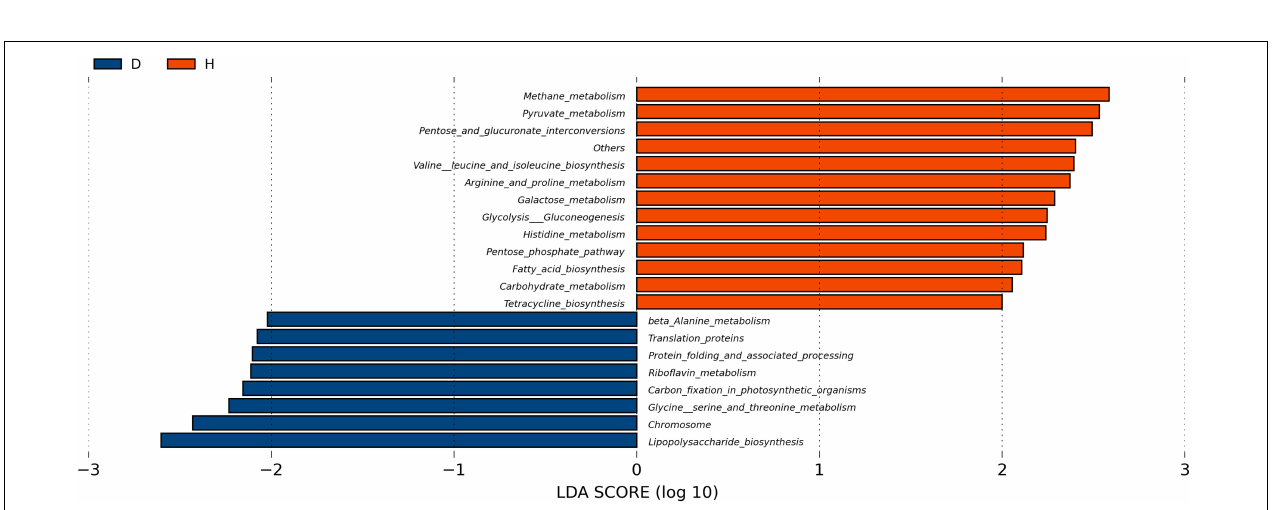
FIGURE 4 | Function analysis of fecal microbiota. PICRUSt (phylogenetic investigation of Communities by reconstruction of unobserved States) studies the phylogenetic investigation of community system evolution through the recessive state. The abscisic is the log value obtained by LDA of KEGG pathway with significant roles in two groups, and different colors indicated that the KEGG pathway was enriched in different groups of samples. (D, Diarrhea; H, Health).